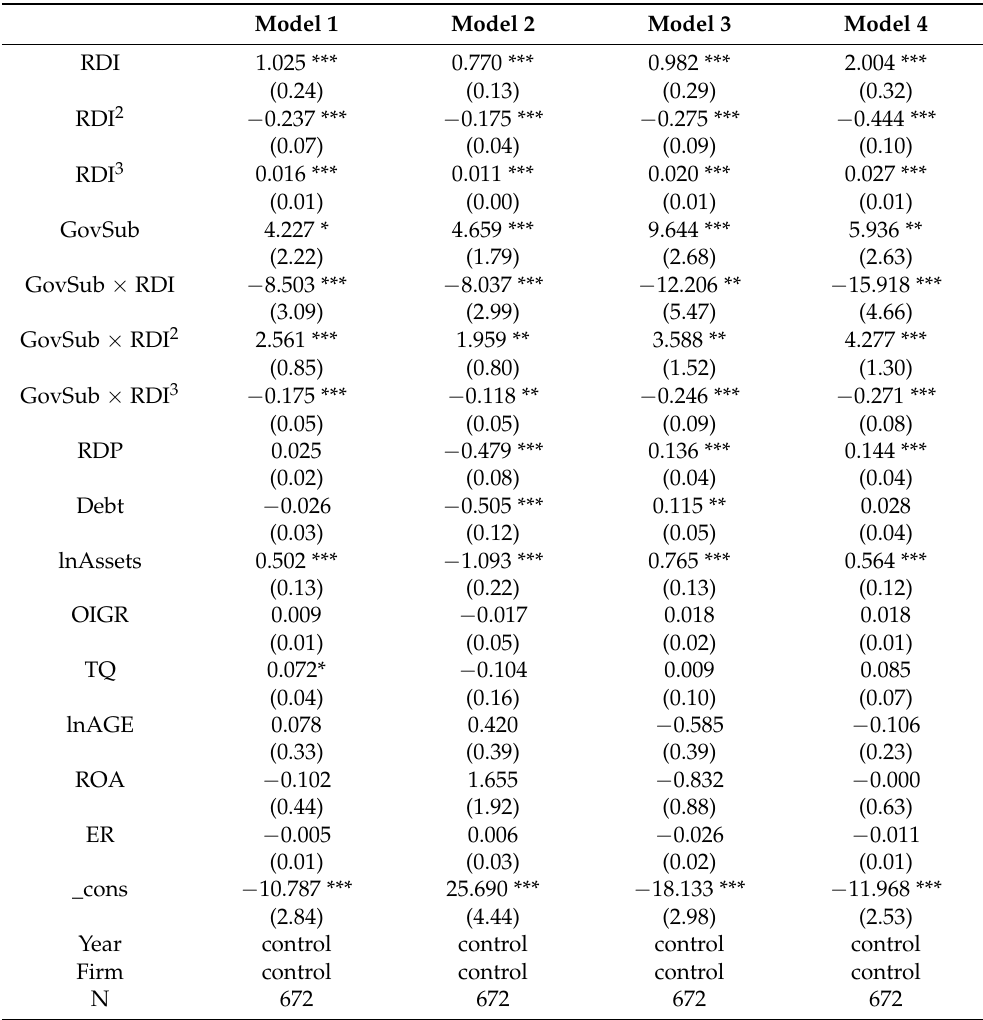
Table 5. Robustness estimation